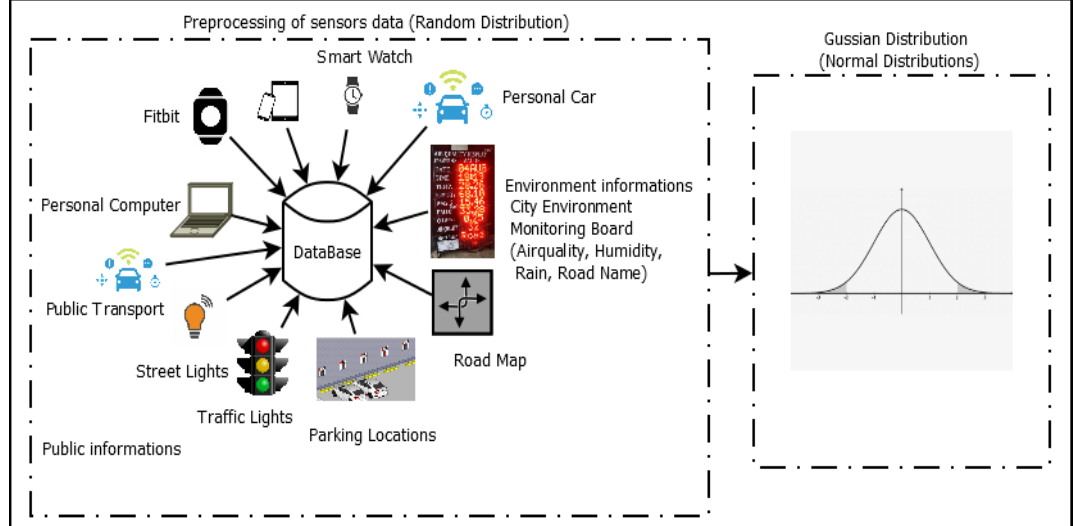
Figure 3. Sensor data–random to Gaussian